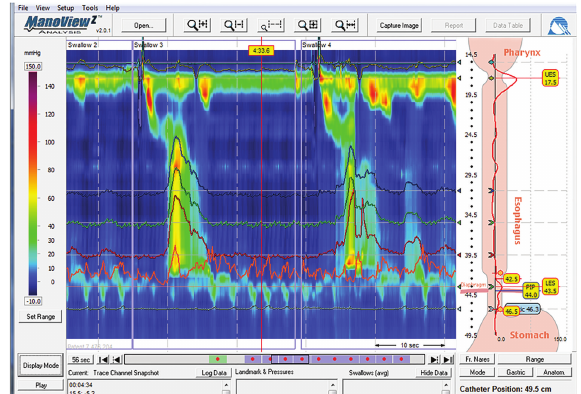
Figure 1: High-resolution manometry study showing hypertensive, nonrelaxing lower esophageal sphincter and aperistaltic esophagus, but with relatively high-amplitude simultaneous pressure changes in the esophageal body.